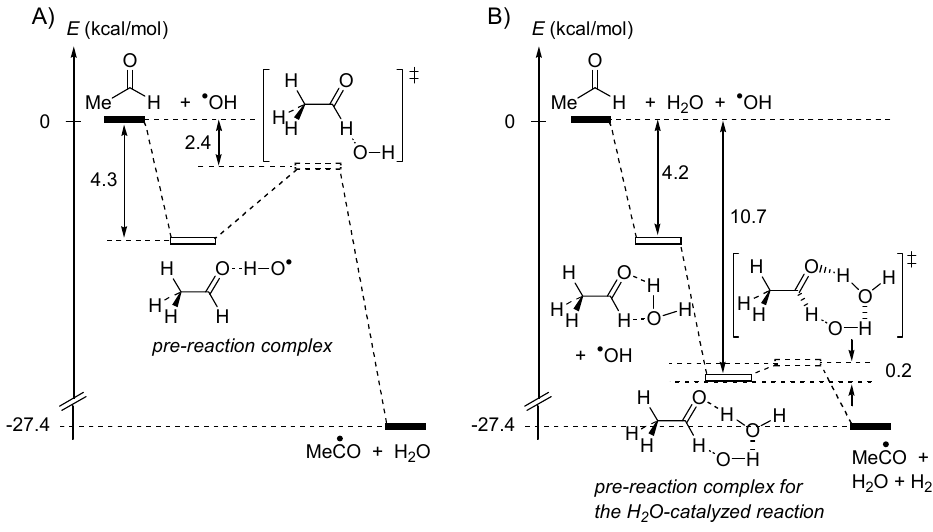
Figure 2. Relative energies ( Δ E ≅ Δ H ) for the reaction MeCHO + • OH → MeC • =O + H 2 O, ( A ) in the absence of H 2 O, ( B ) in the presence of H 2 O.